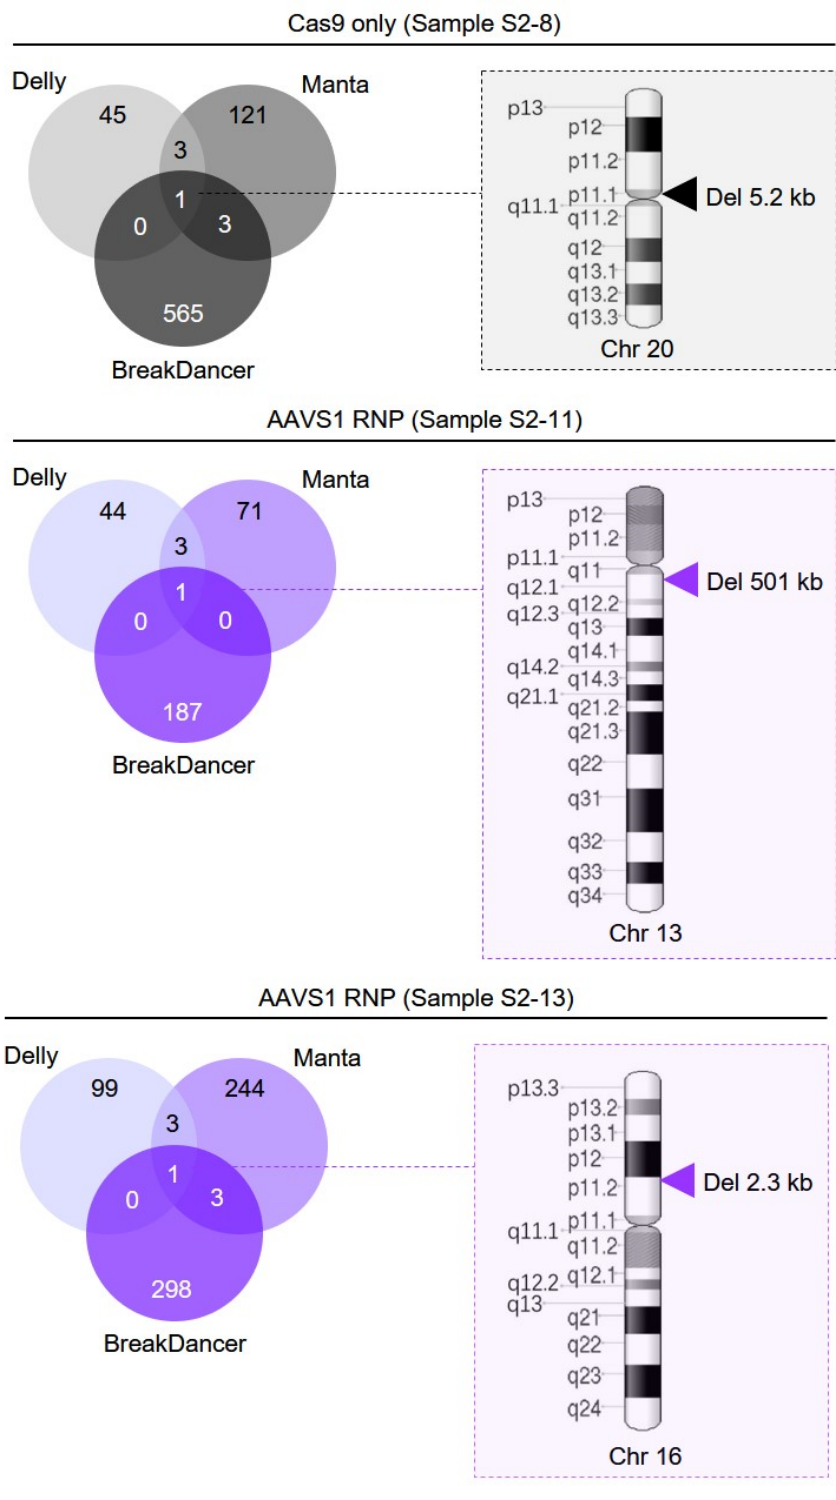
Figure 4. Structural variant (SV) analysis. Venn diagrams representing the intersection of SV calls from three structural variant analysis algorithms, Delly, Manta, and BreakDancer, are depicted for each positive sample from the WGS data set. Schematic diagrams indicating the relative chromosomal location of called SVs for each positive sample are shown. Cytogenetic band designations are indicated at the left of each ideogram. Chromosome image attribution: National Center for Biotechnology Information, U.S. National Library of Medicine/Public domain.